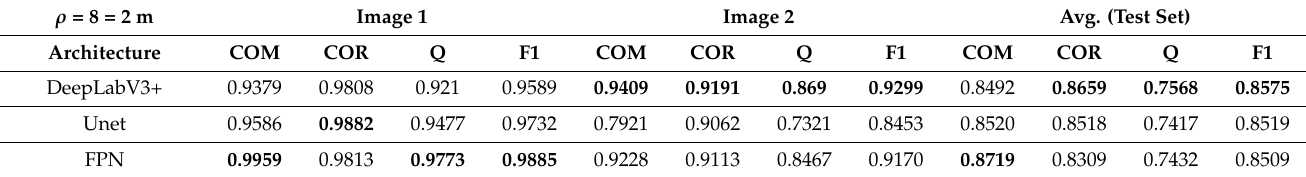
Table 9. Rural road extraction quantitative results for a ρ = 8 (using the Guo–Hall thinning Table 8. Rural road extraction quantitative results for a ρ = 6 (using the Guo–Hall thinning algo- rithm).